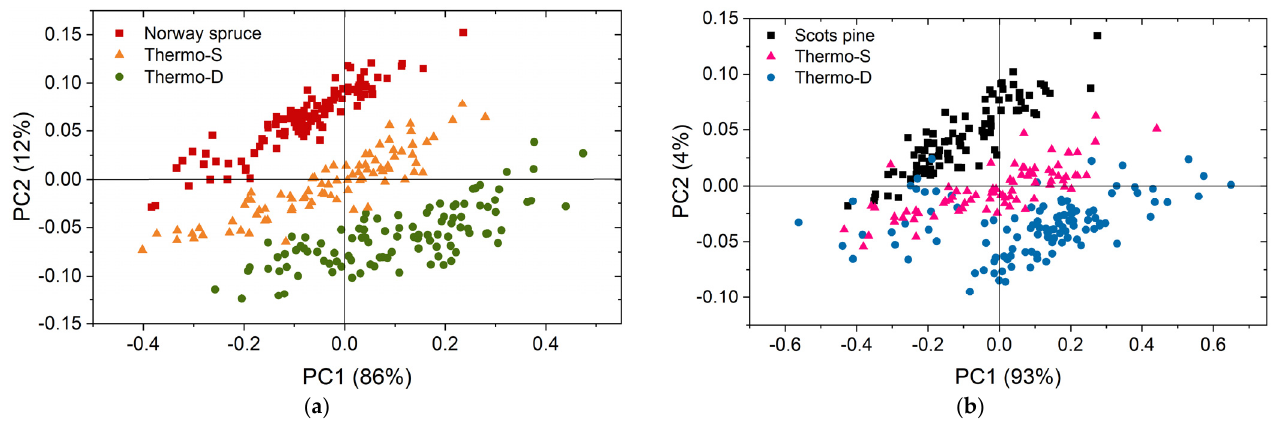
Figure 2. Principal component (PC) scores performed on infrared spectra in the 1400–1185 cm − 1 region for untreated and ThermoWood ® Norway spruce ( a ) and Scots pine ( b ).